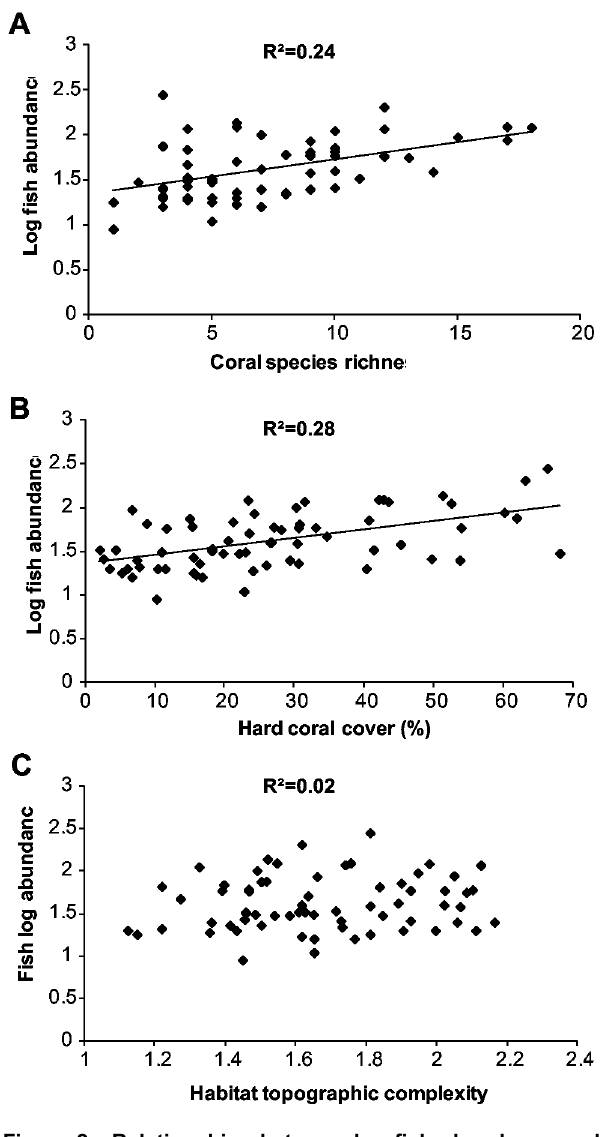
1.39, n = 27) (Figure 5) . Distance-Based Linear Modelling Fish community composition. Distance-based linear models revealed qualitatively similar relationships between habitat variables and the abundances of the 19 most abundant